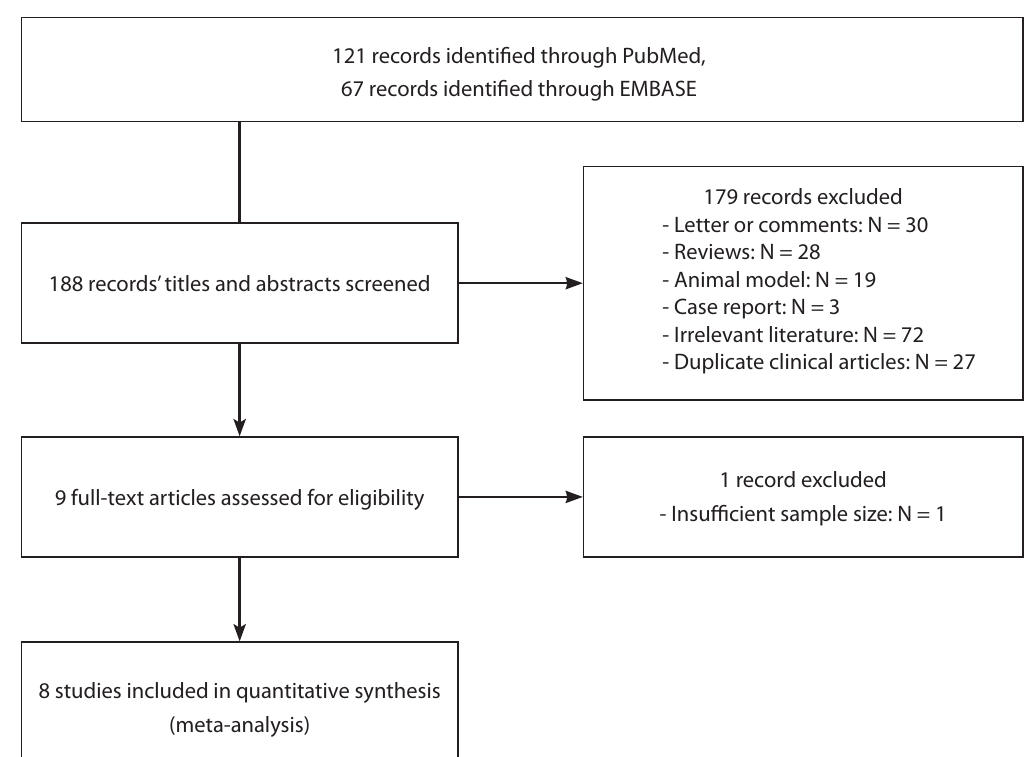
Fig. 1 - Preferred Reporting Items for Systematic Reviews and Meta-Analyses (or PRISMA) flow chart of study selection. EMBASE=Excerpta Medica